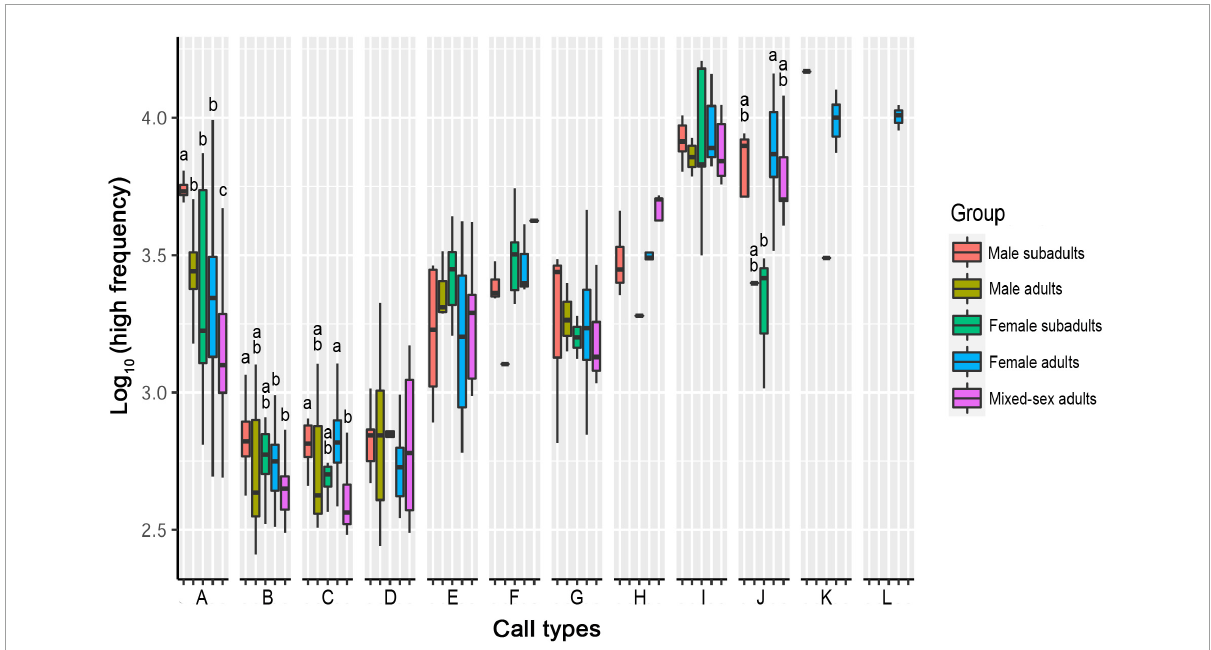
FIGURE5 Differences in high frequencies among five sex–age groups for all call types. The y -axis is the log-transformed value of high frequency. The x -axis represents the call types. Boxplots with different lowercase letters refer to Kruskal–Wallis comparison tests yielding significant results ( P < 0.05), and the relationship among the letters is a > b > c > d. Boxplots with the same lowercase letters did not significantly differ ( P > 0.05). Call types without letters on the boxplots showed no significant differences among sex–age groups.